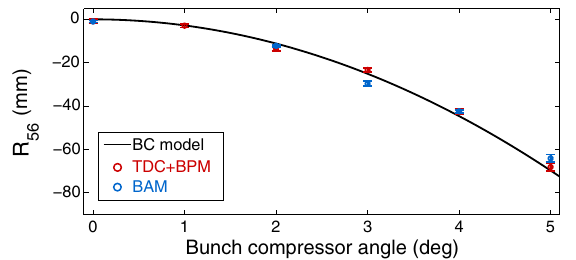
FIG. 56. Comparison of measurements of the R 56 parameter using the transverse deflecting cavity (TDC) and a downstream BPM (red points) and via bunch arrival-time using a BAM (blue points), for different bunch compressor angles.